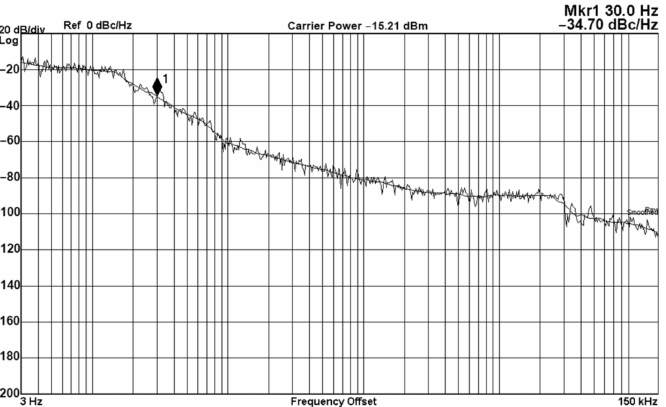
Figure 43. The measured phase noise performance of the VM QSO at the V o5 output terminal.